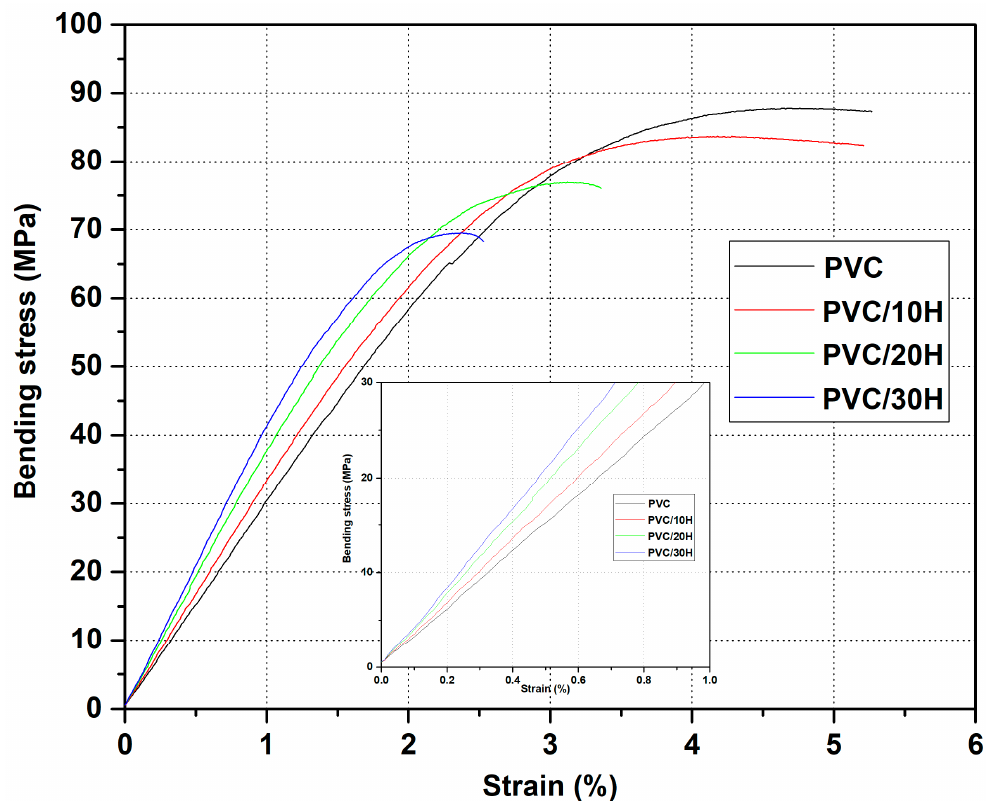
Figure 10. Representative stress–strain curves from the bending test for the PVC composites.